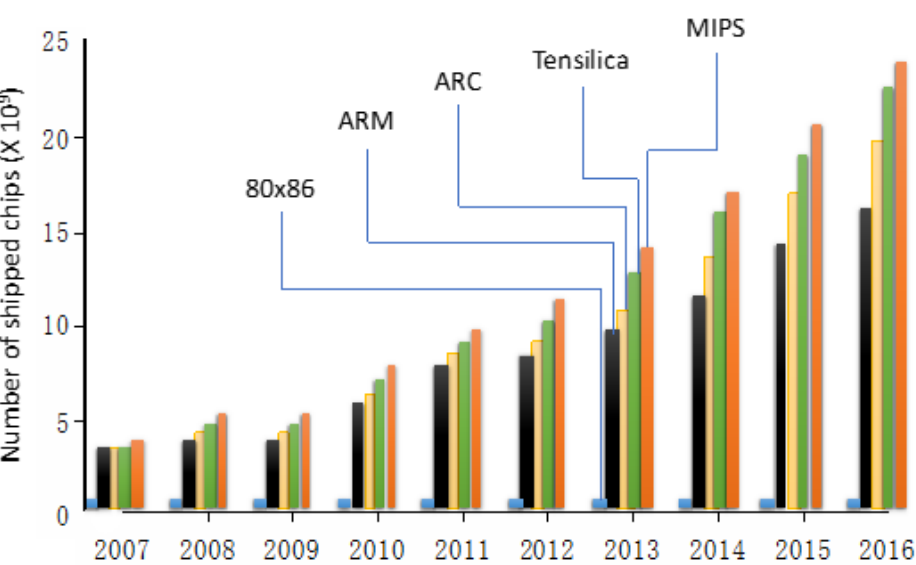
Figure 7. Comparison of the number of RISC chips (ARM, ARC, Tensilica, or MIPS ISAs) versus CISC architecture (Intel’s 80 × 86). RISC, reduced instruction set computer; CISC, complex instruction set computer; ISA, instruction set architecture; ARM, advanced RISC machine.